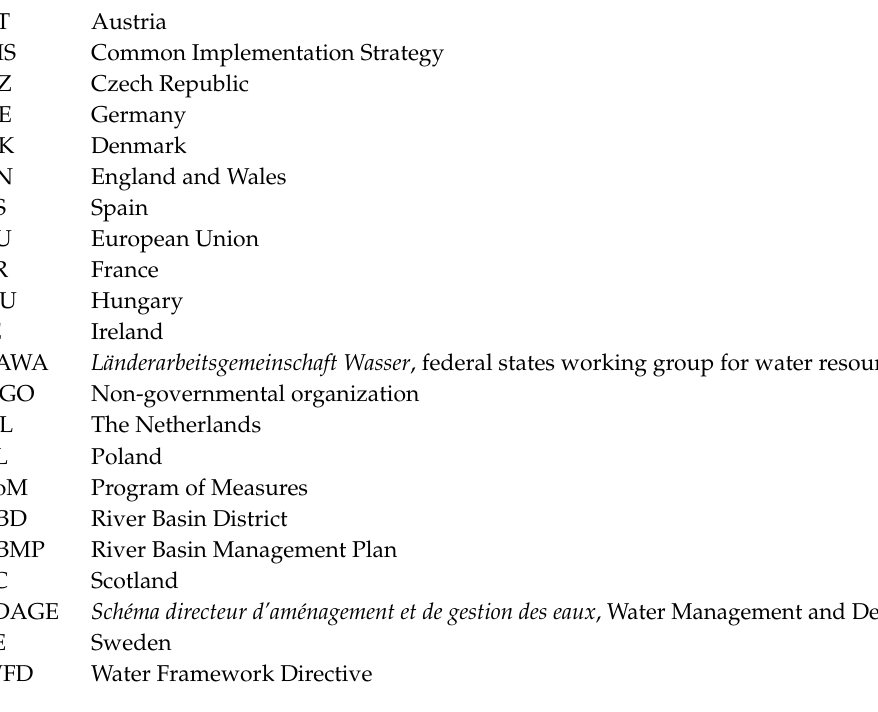
Table S1: Variable descriptions; Table S2: Raw and aggregate data of public participation and river basin management in 13 EU member states for t0 and t1; Table S3: Public Participation in 13 EU member states under the WFD; Text S1: Method of aggregation for indices used; Text S2: Literature drawn on in coding: European water resources management before and after EU Water Framework Directive